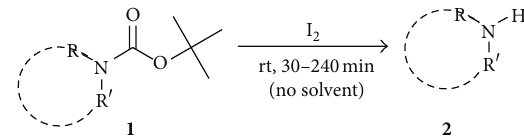
solvent-free conditions.